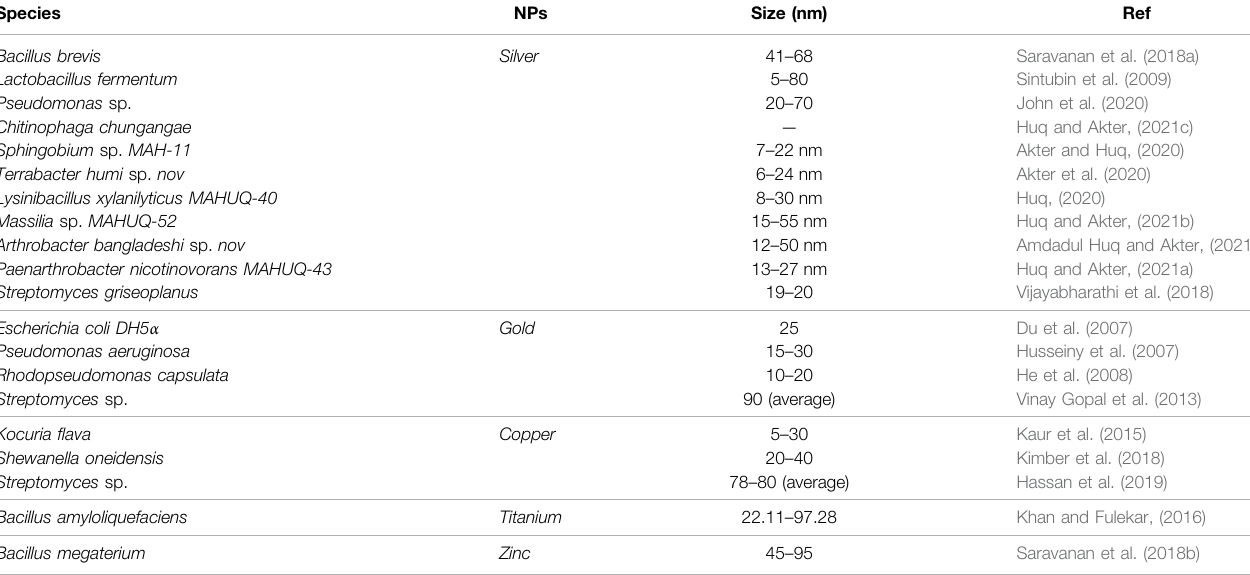
TABLE 3 | Literature overview of various nanoparticles synthesized using bacterial species.